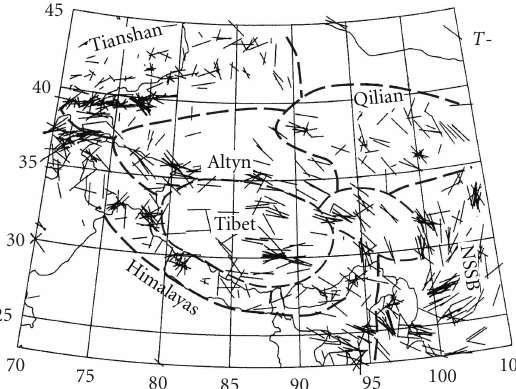
Figure 3: Distribution of compressive axes (P-) in and around the Tibetan plateau.